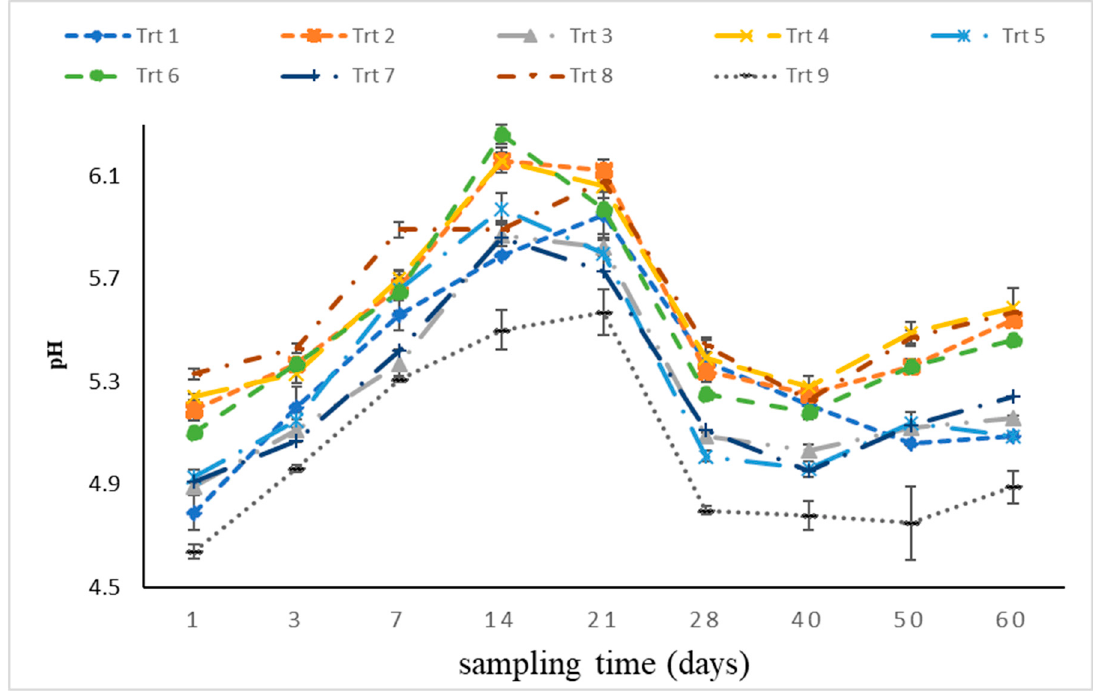
Figure 4. The pH of soils during incubation at different rates of compost application. Key: Trt1: 3:1 −